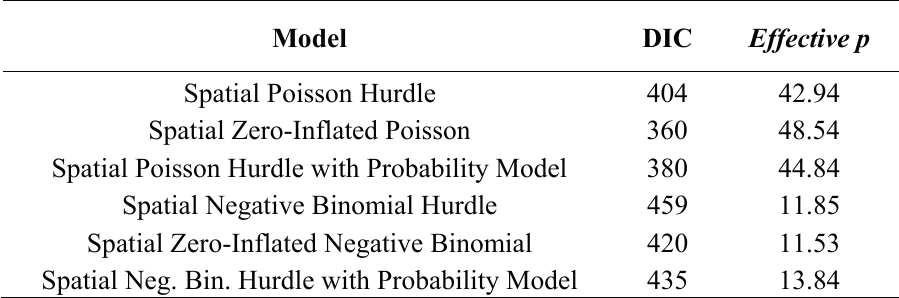
Table 1. Model selection results based on DIC